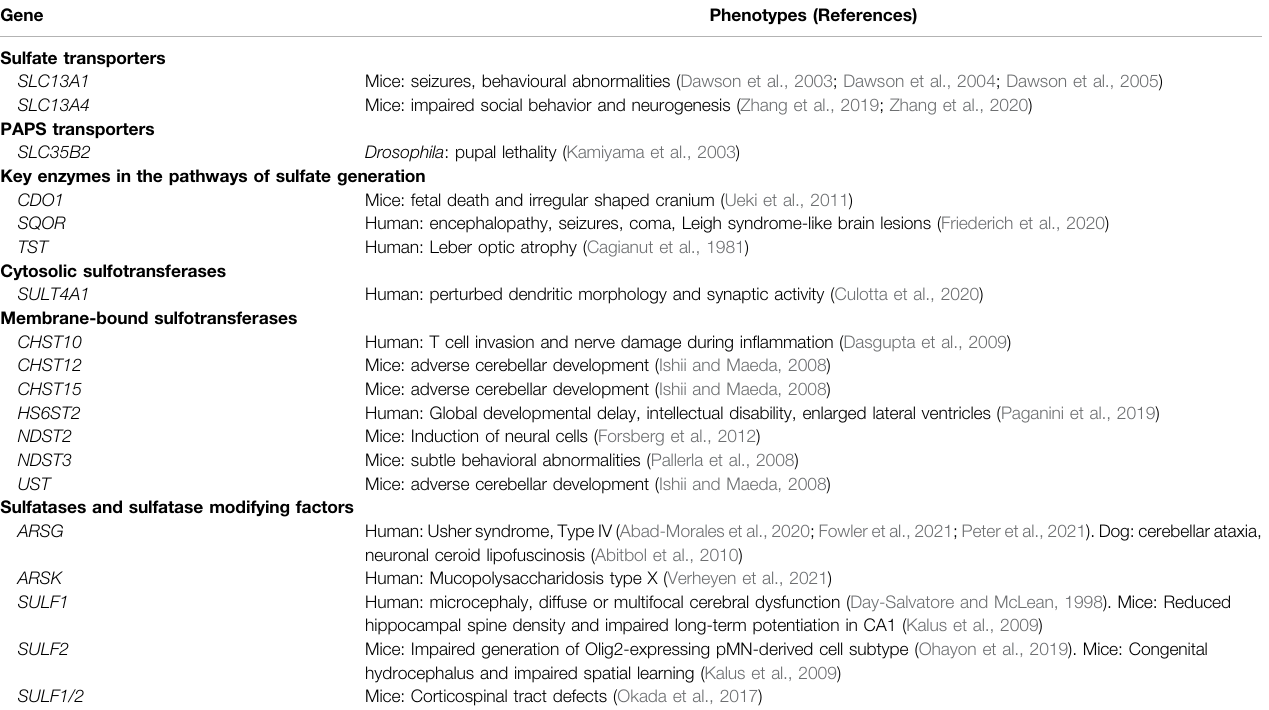
TABLE 2 | Neurological phenotypes reported for sulfate biology genes that are not yet captured in clinical genetics. Gene Phenotypes (References) Sulfate transporters